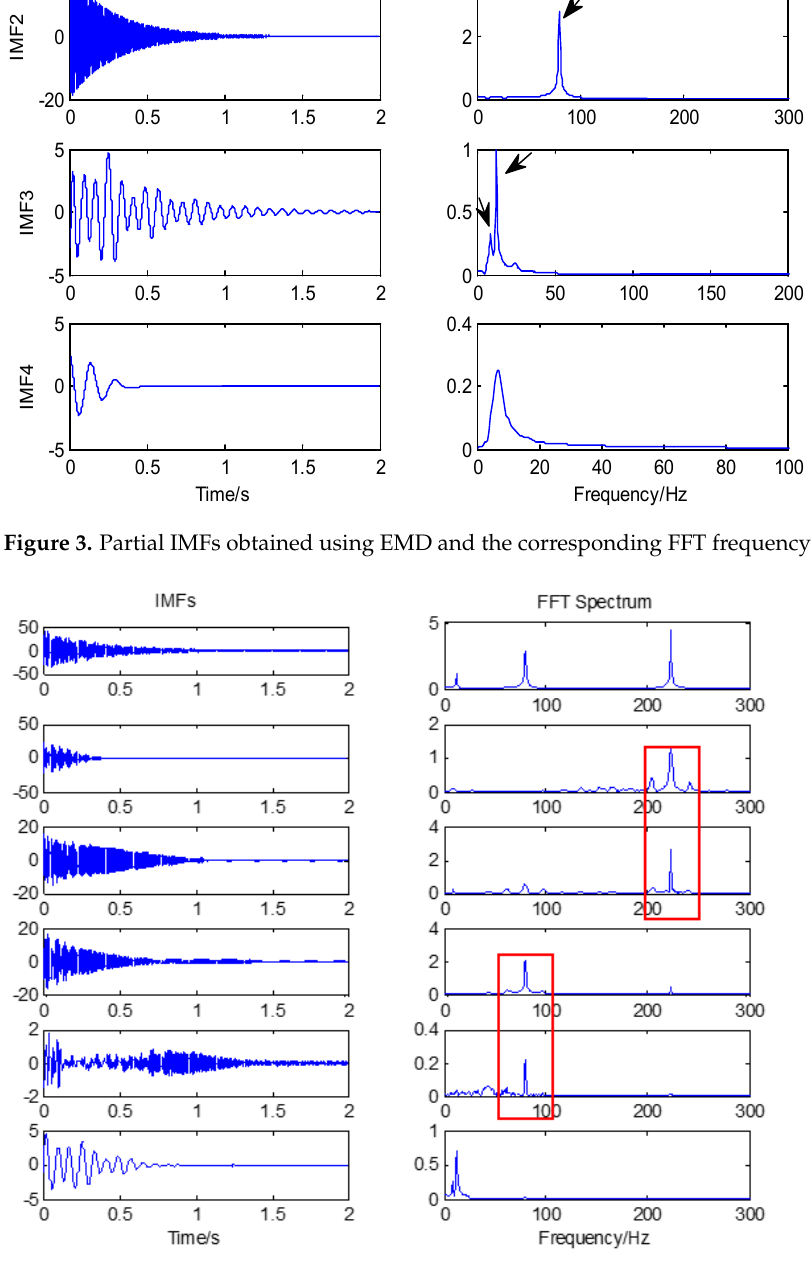
Figure 4. Partial IMF s obtained using EEMD and the corresponding FFT frequency−spectrum.